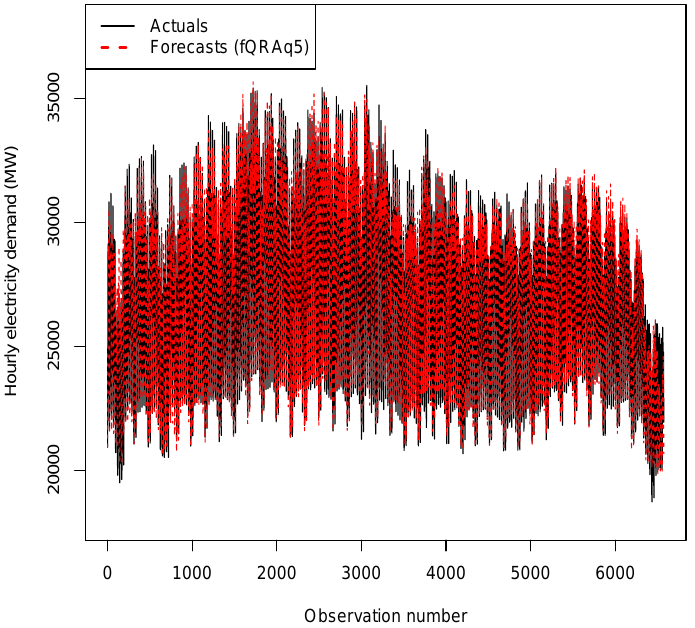
Figure 9. Plot of actual demand superimposed with forecasted demand from M 6 (2 April to 31 December